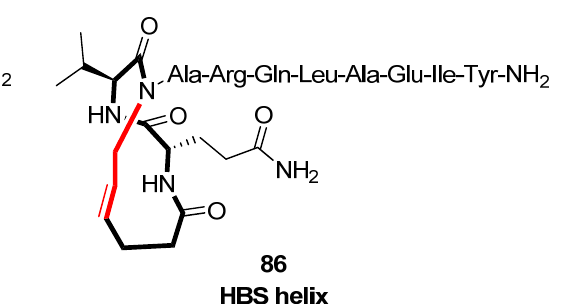
Figure 22. Replacement of an intramolecular H-bond in an α -helix by an RCM-derived covalent link.